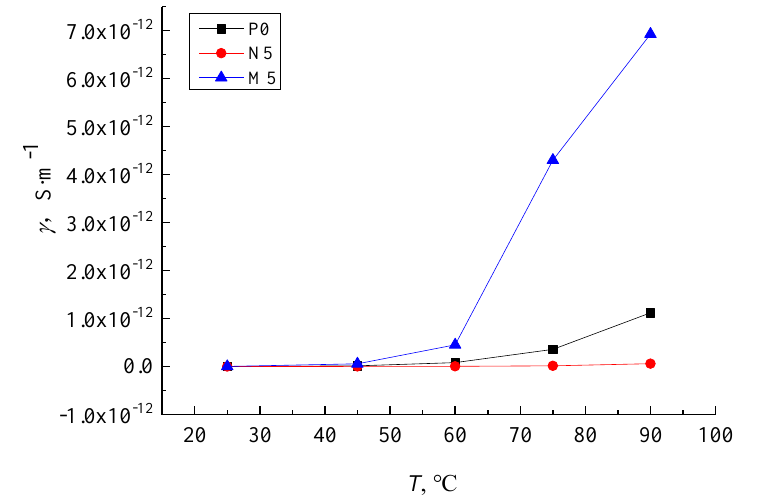
Figure 11. The J-E characteristic curves of LDPE, nano-ZnO/LDPE and micro-ZnO/LDPE in 9 kV/mm.